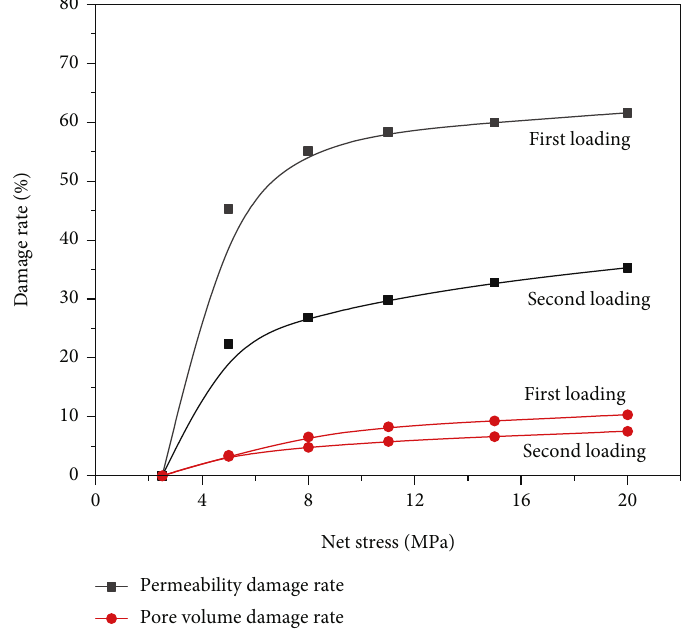
Figure 10: Permeability and pore volume damage rate under di ff erent net